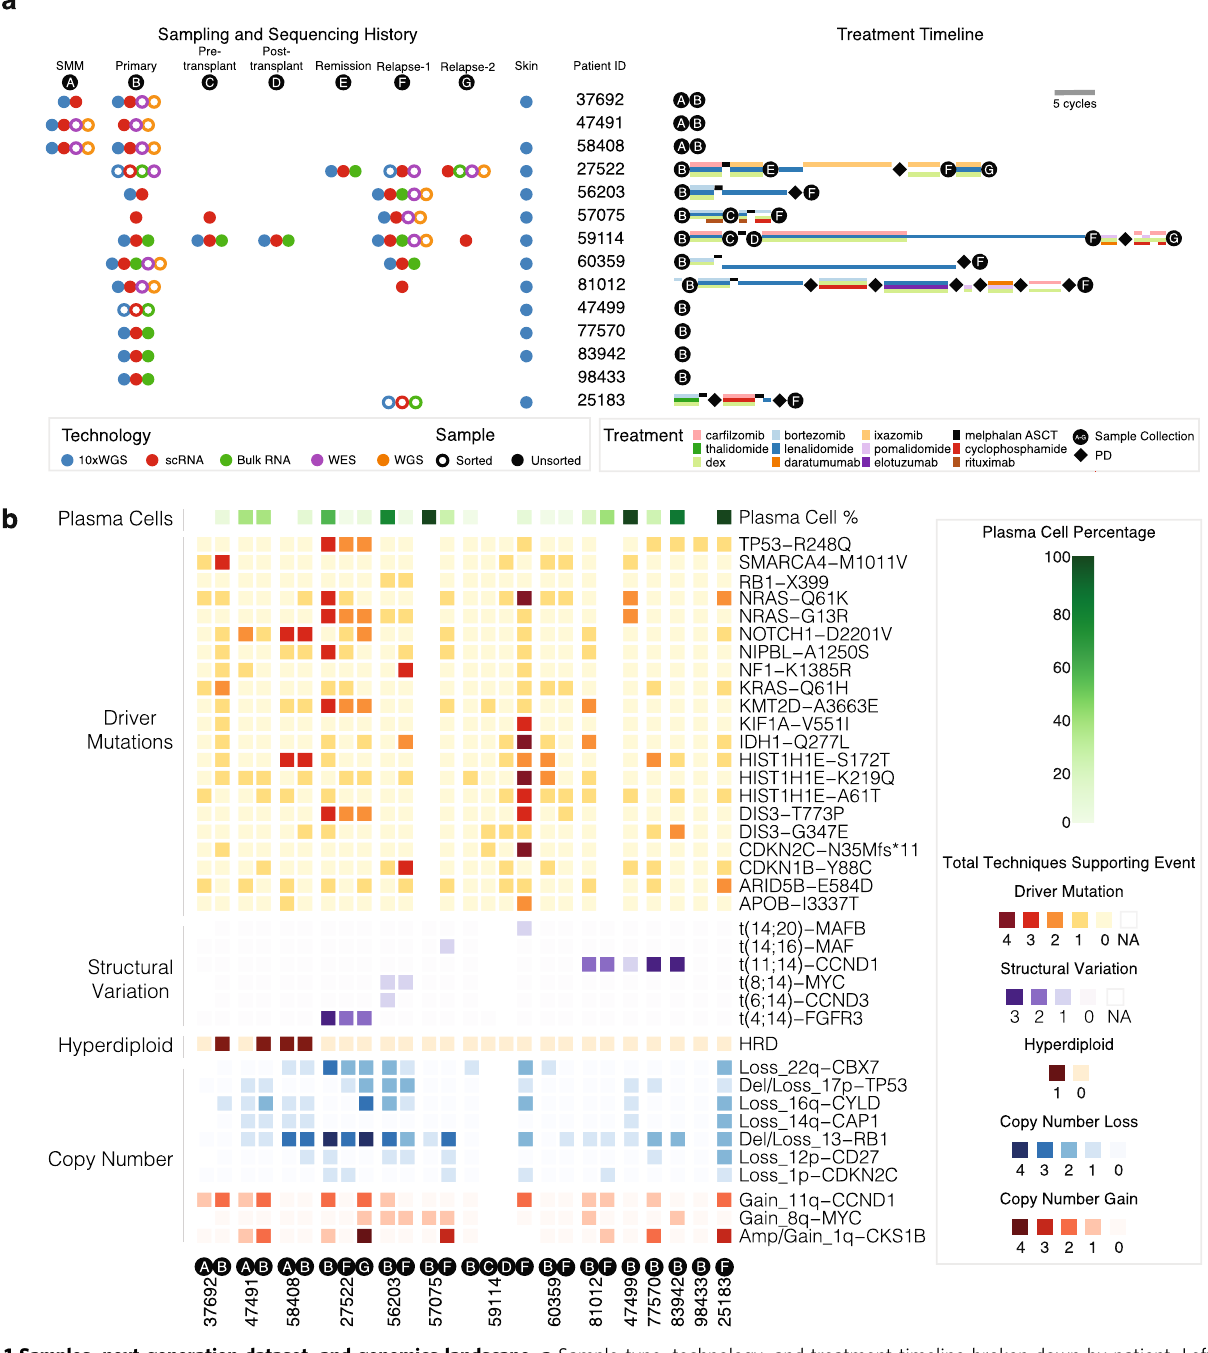
Fig. 1 Samples, next-generation dataset, and genomics landscape. a Sample type, technology, and treatment timeline broken down by patient. Left portion shows sample technology (10xWGS, scRNA, Bulk RNA, WES, WGS) and sample type (CD138 + sorted vs. unsorted). Right portion shows each patient ’ s treatment timeline. Treatment length corresponds to the number of cycles. SMM smoldering multiple myeloma. b Heatmap shows the landscape of copy number variations (CNV), structural variants (SV), and driver mutations across 14 patients. Copy number ampli fi cation/gain, copy number deletion/loss, SV, and driver mutations are shown in red, blue, purple, and orange, respectively, with colors indicating the number of techniques supporting the event. Techniques for copy number events are FISH, 10xWGS, regular WGS, WES, and scRNA-seq. Techniques for SV are FISH, 10xWGS, Bulk RNA- seq, and scRNA-seq. Techniques for driver mutations are 10xWGS, WES, WGS, and Bulk RNA-seq. Number of techniques supporting an event is 0 if the only technique supporting the event is from scRNA-seq. Plasma cells percentage inferred from scRNA-seq is shown on the top of the